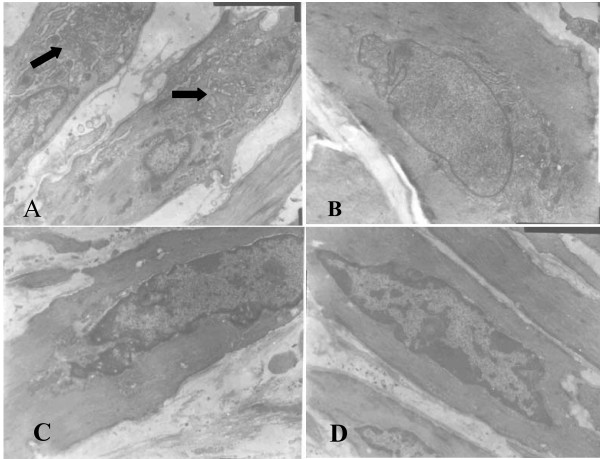
Representative SMC phenotype in neointima observed by transmission electron microscopy (×8000). A: Control; B: Probucol; C: HXS; D: Normal (SMC form tunica media). SMCs of contractile phenotype obtained from tunica media of normal tissue have rich myofilament in cytoplasm and few organelles related to biosynthesis. However, SMCs with synthetic phenotype were more frequently seen in control and they have more organelles (→) related to biosynthesis and fewer myofilament in cytoplasm. Both probucol and XS0601 inhibited transition of SMC phenotype from the contractile to the synthetic, especially in HXS where less increased organelles related to biosynthesis were found.